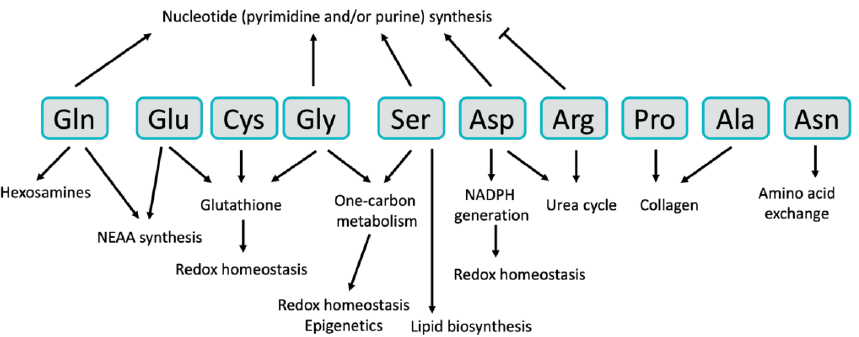
Figure 2. The Diverse Functional Roles of NEAA in cancer. Non-essential amino acids have diverse functions in cancer cells. NADPH = Nicotinamide adenine dinucleotide phosphate